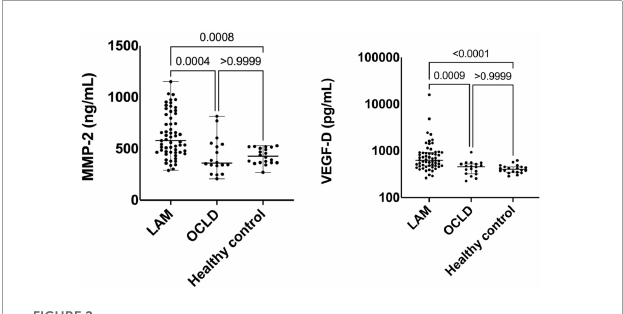
FIGURE2 Comparison of serum metalloproteinase-2 (MMP-2) and vascular endothelial growth factor-D (VEGF-D) levels between lymphangioleiomyomatosis (LAM) patients, other cystic lung diseases (OCLD), and healthy controls. Solid lines indicate median and interquartile range (IQR).